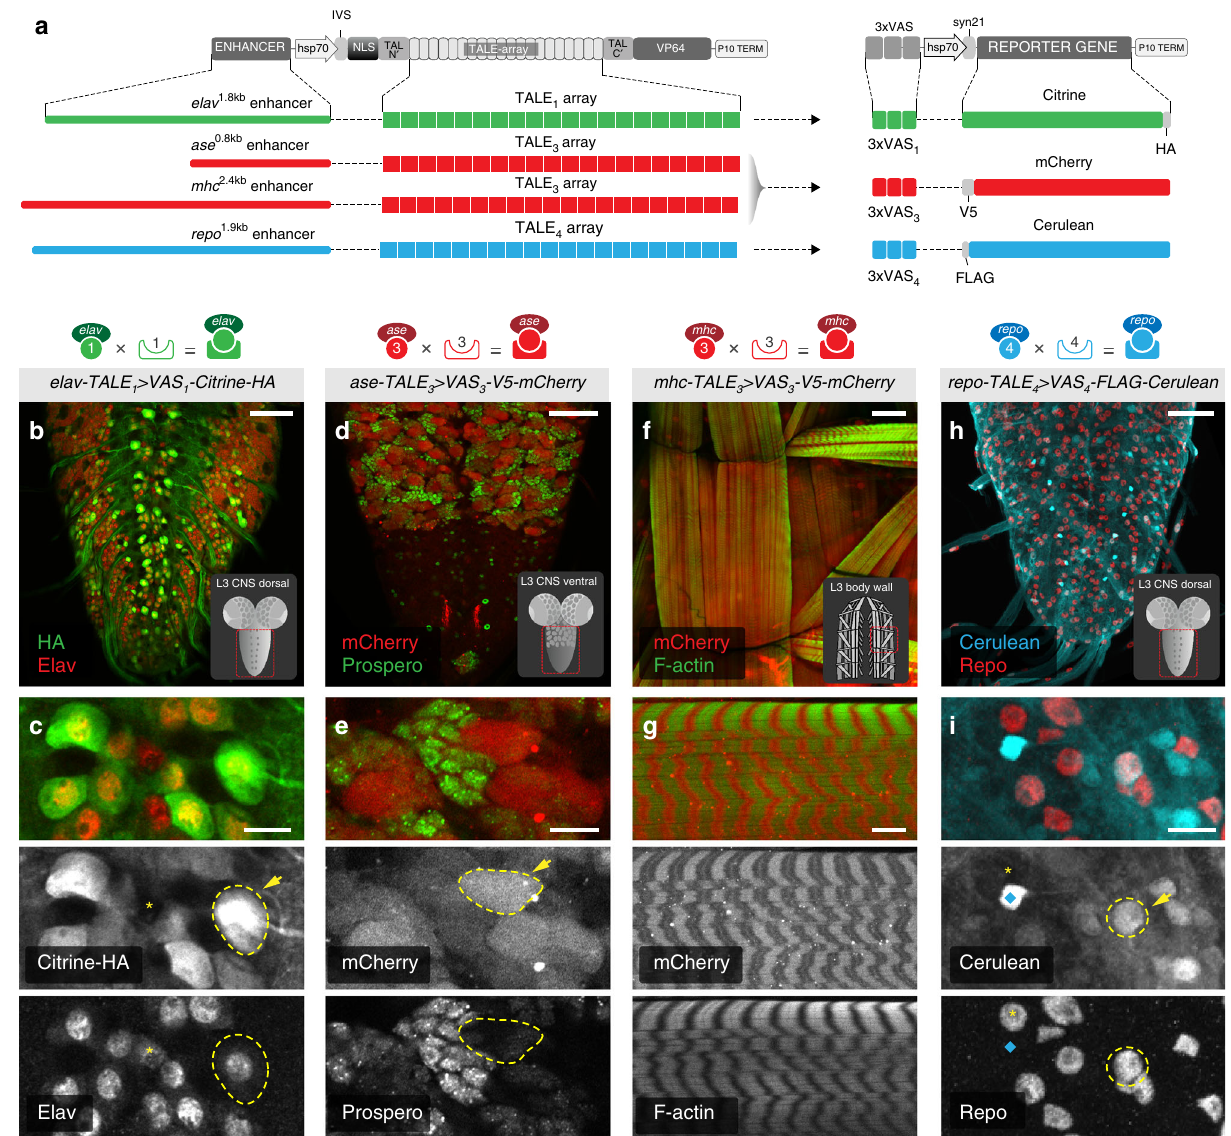
Fig. 2 Implementation of TALE – VAS binary expression systems in vivo. a Schematic representation of the TALE – VAS constructs used in fl ies. The elav 1.8kb , ase 0.8kb , mhc 2.4kb , and repo 1.9kb enhancers were cloned upstream of TALE 1, 3, 4 , and the corresponding 3× VAS sequences were placed in front of Citrine, mCherry, and Cerulean. b – i TALE – VAS-based targeted gene expression in single tissues. Insets show imaging location within each target tissue (red frame). b Dorsal view of elav 1.8kb - TALE 1 > VAS 1 - Citrine-HA third instar larval ventral nerve cord (VNC) stained with anti-HA (transgene expression) and anti-Elav antibody (neuronal marker). c Close up illustrating the overlap between Citrine-HA and nuclear Elav staining in neurons (yellow dashed line and arrow). Some Elav-positive cells lack Citrine-HA expression (yellow asterisk). d Ventral view of ase 0.8kb - TALE 3 > VAS 3 - V5-mCherry third instar larval VNC showing mCherry expression in neuroblasts (red) and Prospero staining of ganglion mother cells (anti-Pros antibody, green). e Detailed, high magni fi cation of a single neuroblast (yellow dashed outline and arrow) and surrounding ganglion mother cells (green). f Third instar larval body wall musculature from mhc 2.4kb - TALE > VAS V5-mCherry at low magni fi cation. g High-magni fi cation sarcomere morphology showing alternating bands of mCherry expression 3 3 - and F-actin characteristic of striated muscles. h repo 1.9kb - TALE 4 > VAS 4 FLAG-Cerulean third instar larval VNC stained with an anti-GFP antibody (transgene expression) and anti-Repo (glia marker). i Detailed view of subperineural glia showing cells that stain positive for both Cerulean and Repo (yellow dashed outline and arrow) express only Cerulean (blue diamond) or only Repo (yellow asterisk). Scale bars = 50 µ m ( b , d , f , h ), 10 µ m ( c , e , g , i